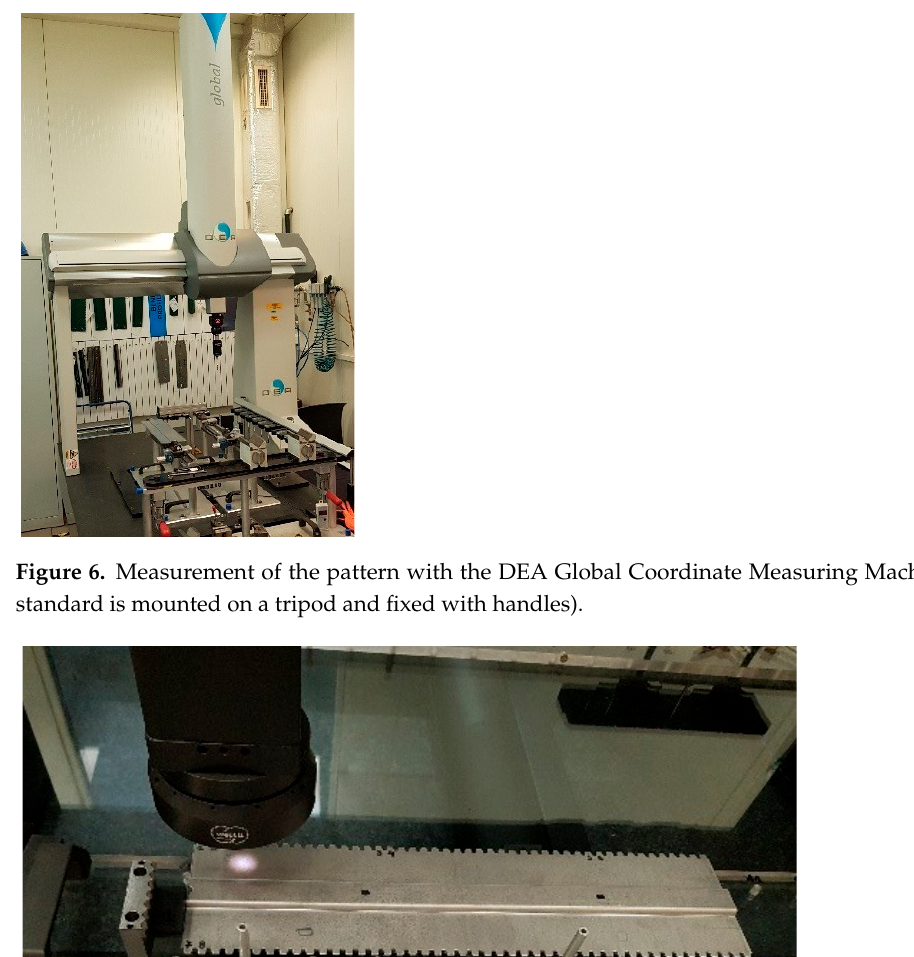
Figure 6. Measurement of the pattern with the DEA Global Coordinate Measuring Machine (the standard is mounted on a tripod and fixed with handles).